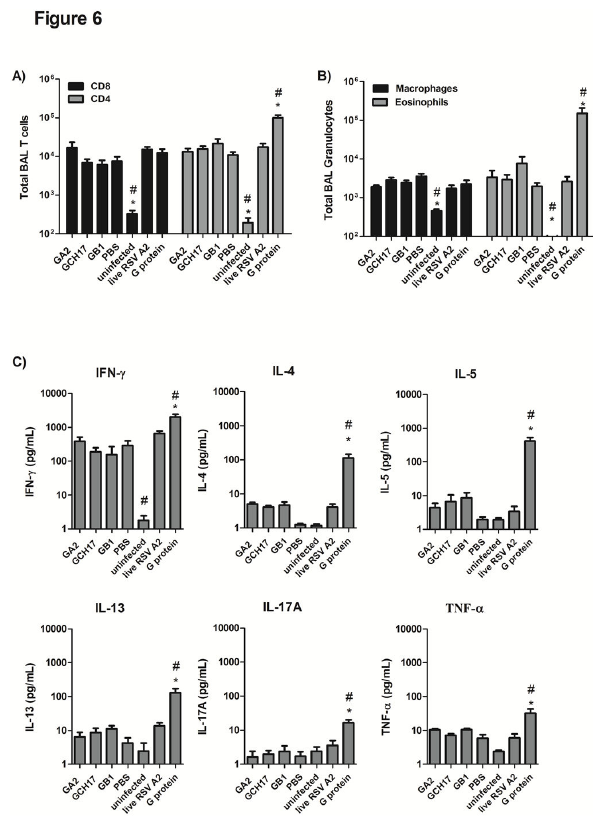
Figure 6. Pulmonary cell recruitment and cytokine production upon RSV infection. Mice were vaccinated with 50 µg of RSV G nanoparticles, 10 µg of purified G protein emulsified 1:1 with TiterMAX®, 10 5 PFU of live RSV A2 or with 100 µL of PBS and challenged at 6 weeks post boost with 10 6 PFU of RSV A2. BAL were collected at day 5 post challenge and cell suspensions were immunolabeled with anti-CD3 PE, anti-CD8 FITC and anti-CD4 PerCPCy5.5 to characterize T cells (A) or with a combination of anti-CD45 PerCP-Cy5.5, anti- siglec F PE and anti-CD11c FITC to detect eosinophils (B, grey bars) and macrophages (B, black bars). Based on cell surface markers eosinophils were defined as CD45 + SiglecF + CD11c low cells and alveolar macrophages as CD45 + SiglecF + CD11c high cells. The data are presented as the total number of cells. Values represent mean ± SEM of cells per BAL (n=5). The level of IFN-γ, IL-4, IL-5, IL-13, IL-17A and TNF-α (C) were measured in BAL supernatant by Luminex assay, and the data are presented as picograms of cytokine/ mL of BAL supernatant (n=5). *, #, p<0.05, significant difference as determined by one-way ANOVA and Dunnett’s test, compared with PBS vaccinated control mice (*) or compared to live RSV A2 vaccinated mice